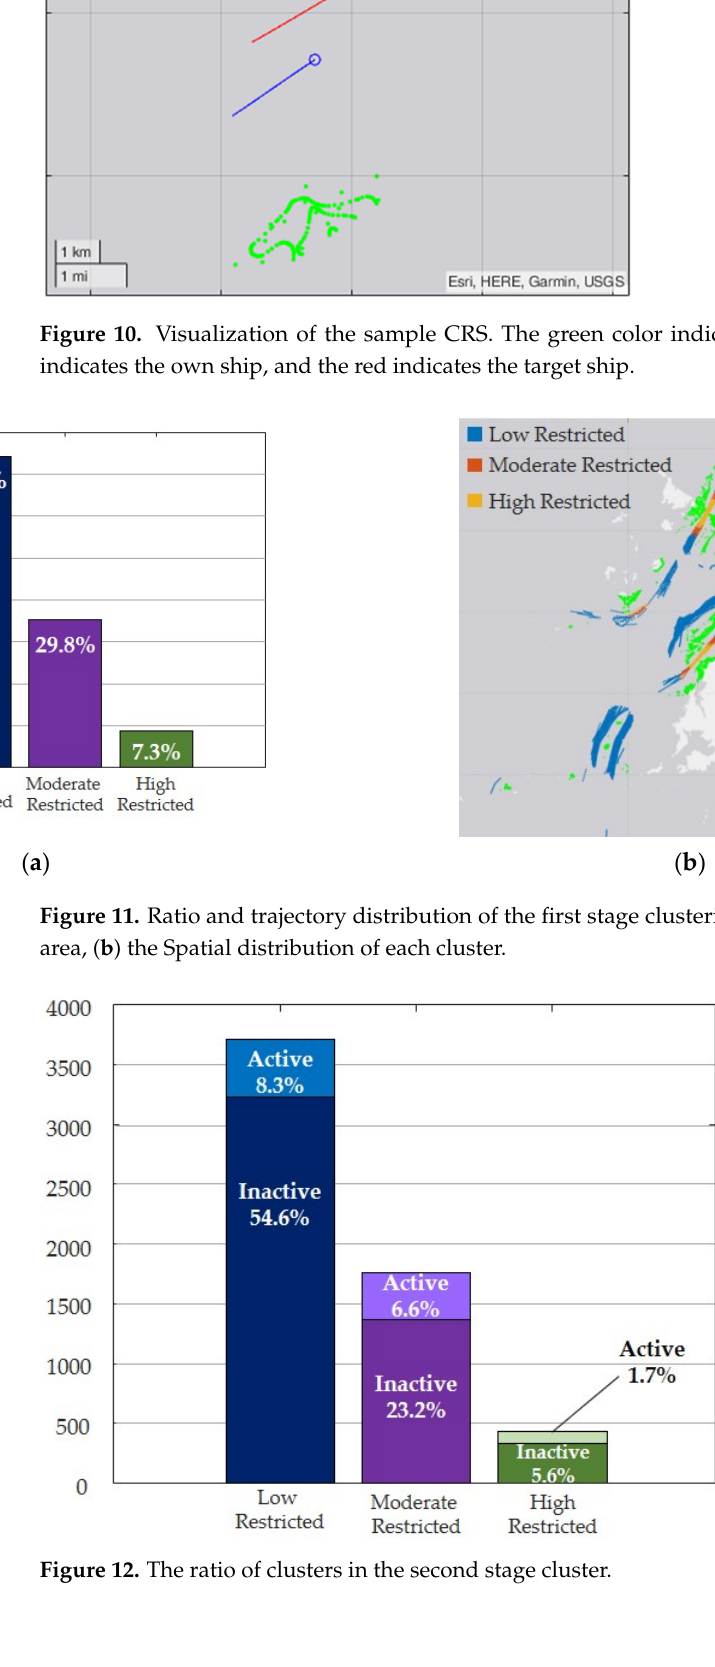
Figure 10. Visualization of the sample CRS. The green color indicates the ENC object, the blue indicates the own ship, and the red indicates the target ship.